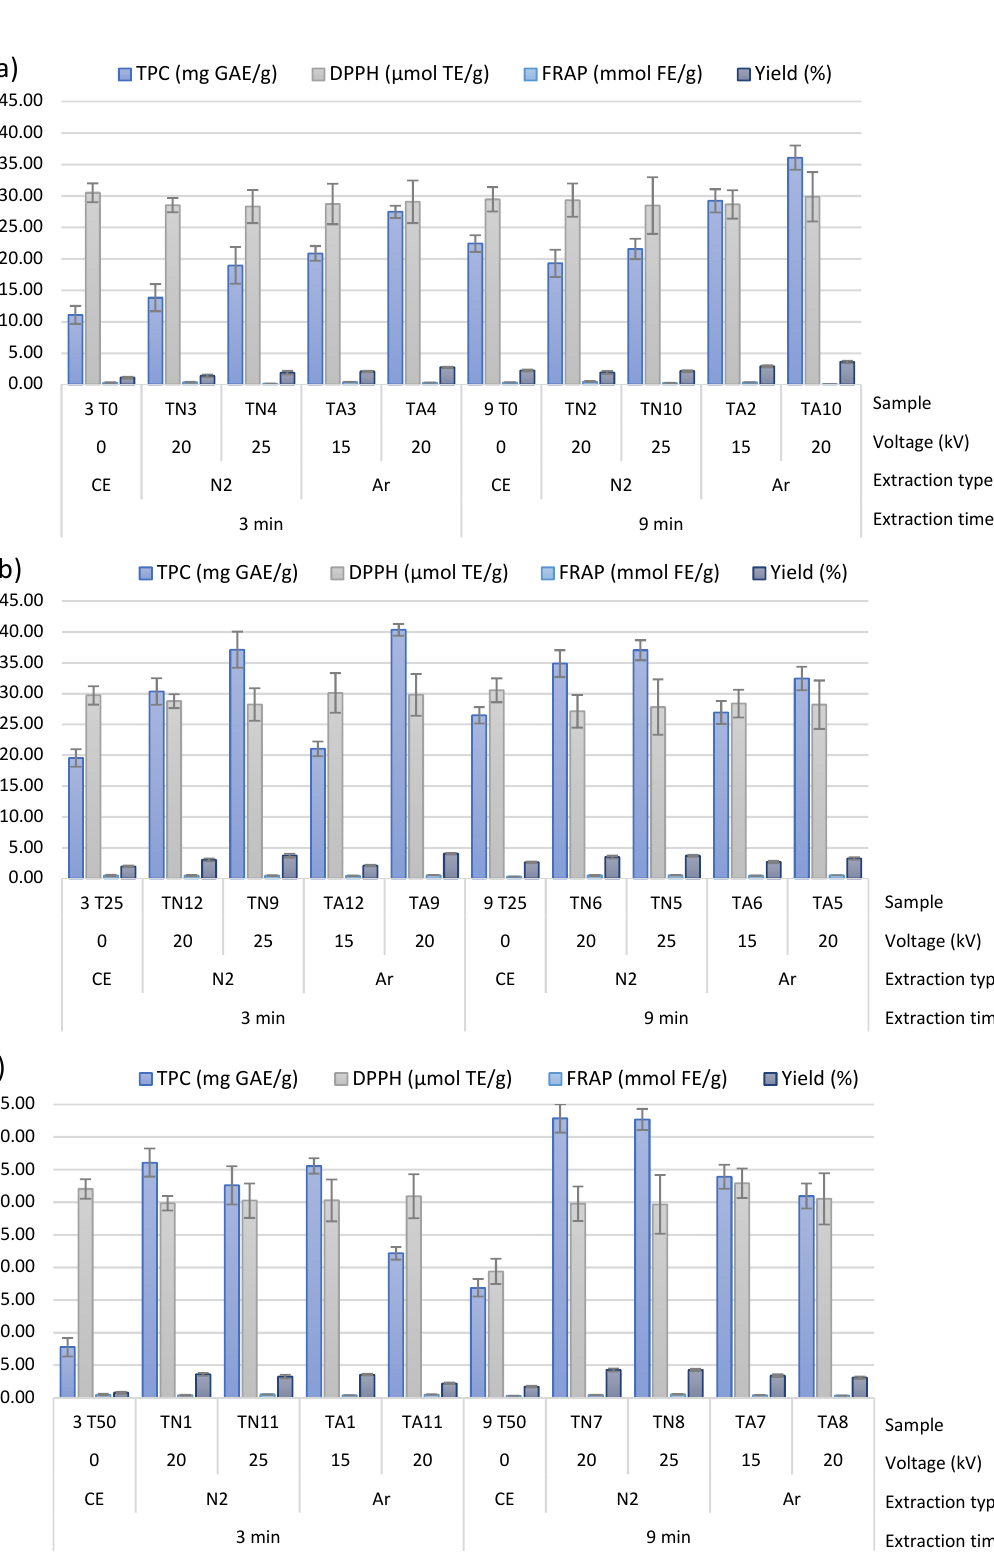
Figure 2. Determination of bioactive compounds—total phenolic compounds (TPC) values, antioxidant activity (DPPH, FRAP) and yield—measurements for CE and HVED treated samples when: ( a ) water was used as a solvent, ( b ) 25% ethanol was used as a solvent, ( c ) 50% ethanol was used as a solvent. Extraction type: CE—conventional extraction, N 2 —HVED extraction with nitrogen, Ar-HVED extraction with argon.